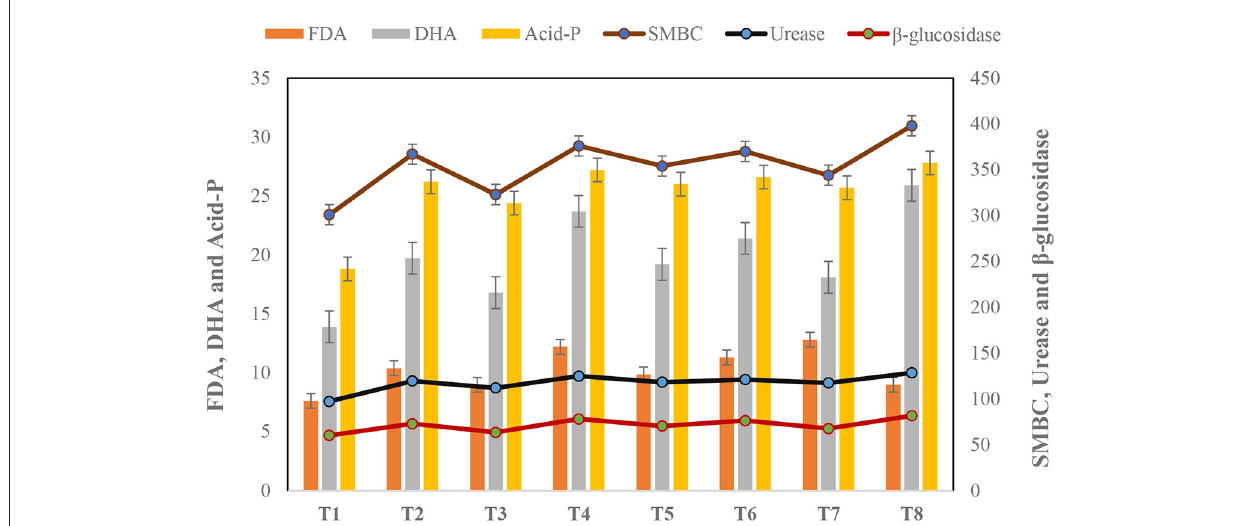
FIGURE5 Effect of the conjoint application of different organic sources of nutrients on the biological properties of the soil after completion of the two years cropping system. SMBC, soil microbial biomass carbon ( µ g g − 1 soil); FDA, mg kg − 1 soil h − 1 ; DHA, µ g TPF g − 1 soil h − 1 ; Acid-P, µ g PNP g − 1 soil h − 1 ; Urease, µ g NH 4 -N g − 1 soil h − 1 ; β -glucosidase, µ g PNP g − 1 soil h − 1 ; T1—farmers’ practice (FYM ∼ 50% RDN); T2—100% RDN through FYM; T3—100% RDN through mixed compost (MC); T4—100% RDN through vermicompost (VC); T5—50% RDN through FYM + 50% RDN through MC; T6—50%